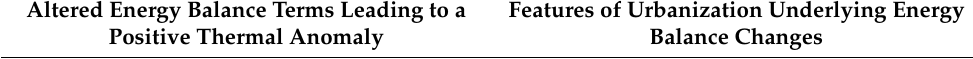
Table 1. Potential causes of UHI [35].